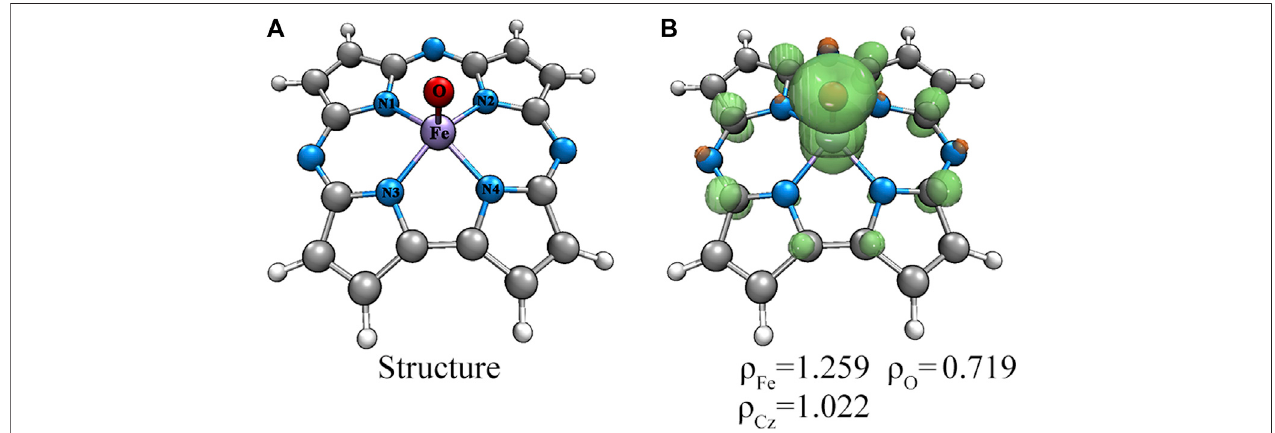
FIGURE 2 | Structure (A) and spin densities (B) of the quartet Fe(IV)-Oxo-Cz.